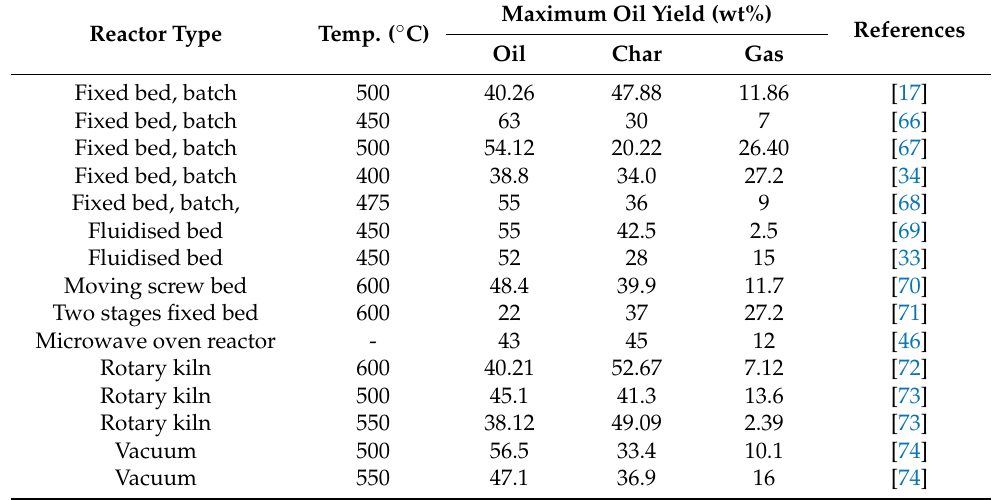
Table 1. Various amount of product yield from waste tyre using pyrolysis